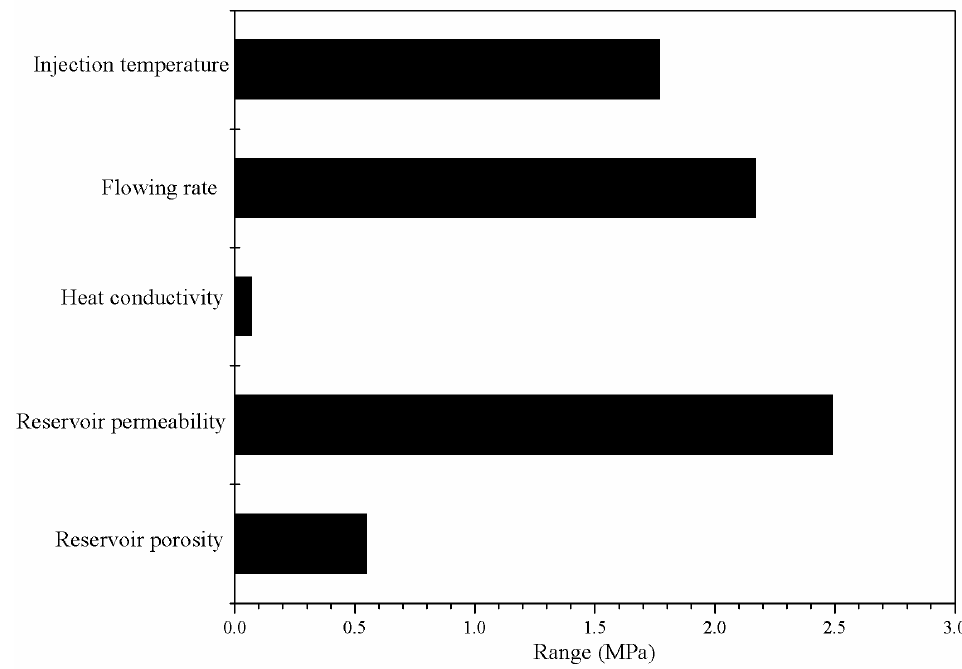
Figure 6. Ranking of the five conditions of the influential effects on the injection pressure.